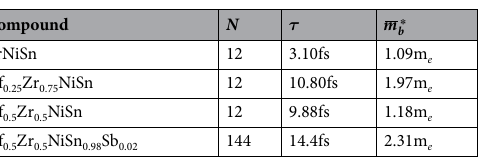
Table 2. The total number of atoms ( N ), the relaxation time at 700 K, the average energy band effective mass near the CBM of ZrNiSn,